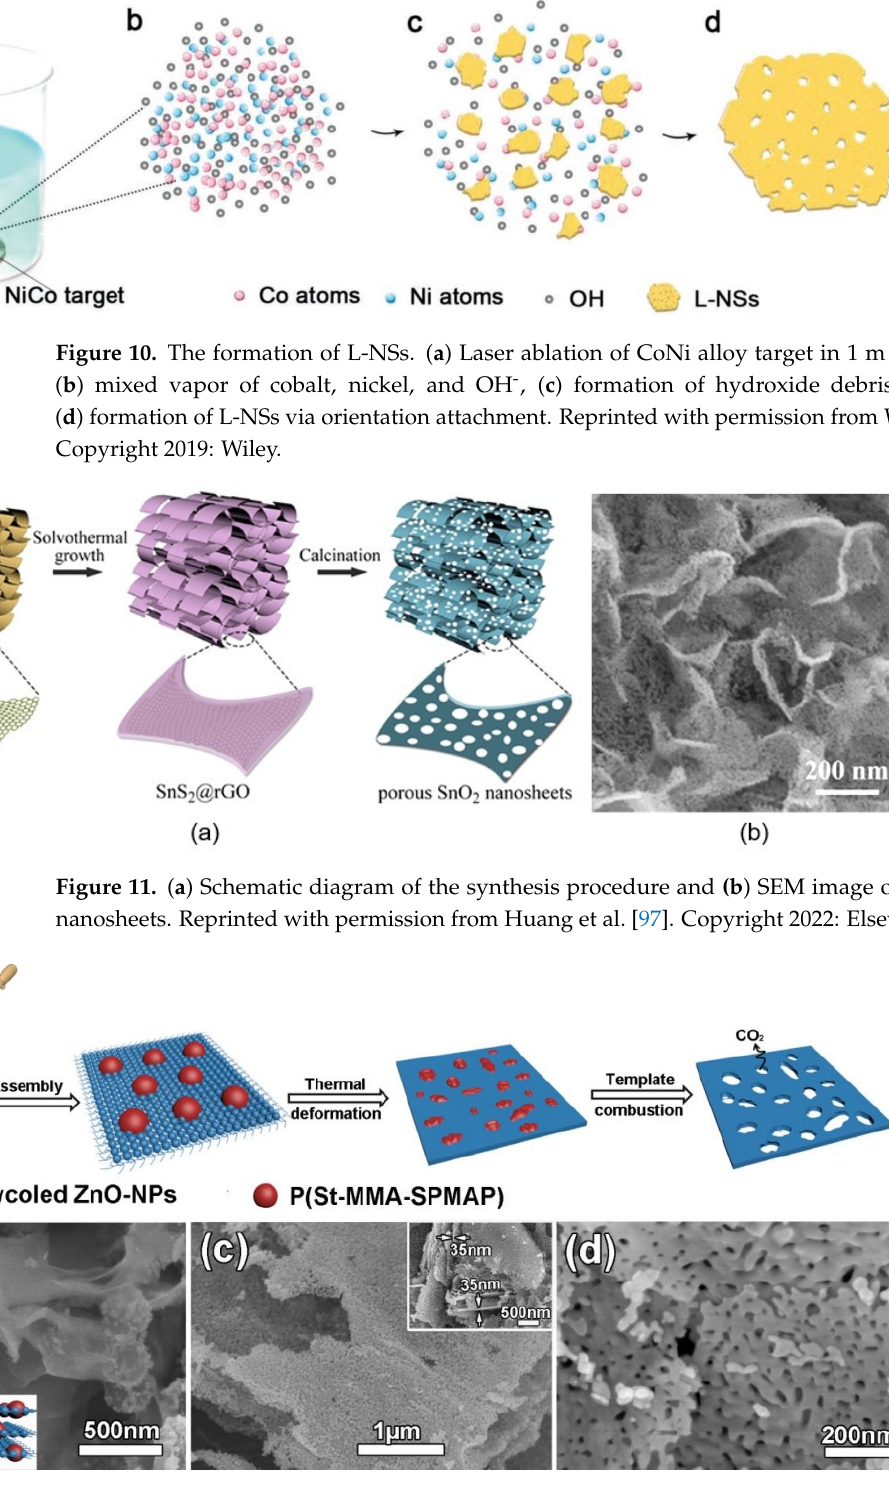
Figure 12. ( a ) Schematic illustration of the ZnO ‐ MSN synthesis, ( b ) SEM images of the layer assem ‐ bled ZnO/P(St ‐ MMA ‐ SPMAP) composites with the inset showing the perspective view of schematic image, ( c ) low magnification SEM image with the inset showing the thickness of ZnO ‐ MSN and ( d ) high magnification SEM image of ZnO ‐ MSN. Reprinted with permission from Liu et al. [98]. Copy ‐ right 2016: Elsevier. 6. Performances of Gas Sensors Based on Porous 2D Nanostructures As shown in Table S1, porous nanosheets and nanoflakes of various materials, from binary metal oxides to complex compounds, such as LaFe 1 ‐ x P x O 3 ‐δ [99], have been tested for the manufacture of gas sensors. However, the main 2D materials used to manufacture gas sensors are still metal oxides such as ZnO [39,100,101], WO 3 [90], In 2 O 3 [102,103], SnO 2